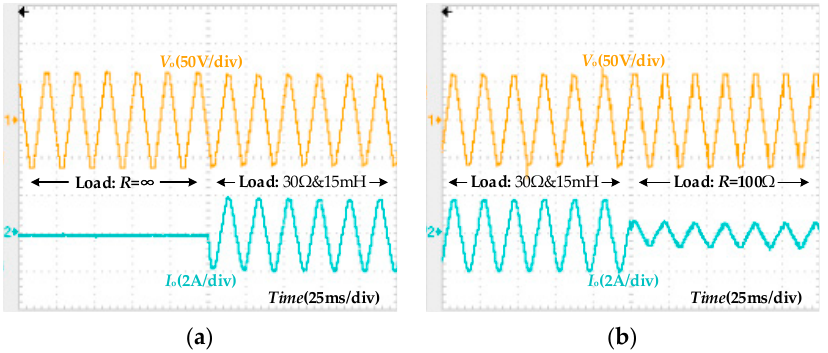
Figure 20. Experiment results when the load changes. ( a ) Load changes from R = ∞ to RL -load. ( b ) Load changes from RL -load to R -load.